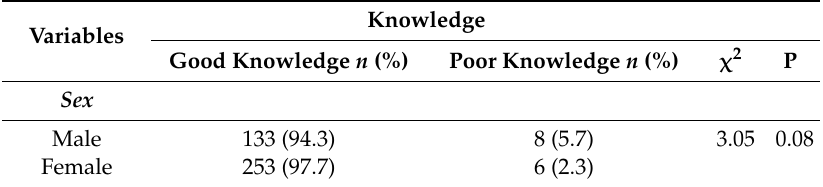
Table 3. Differences in distribution of knowledge about HIV and AIDS for all respondents by